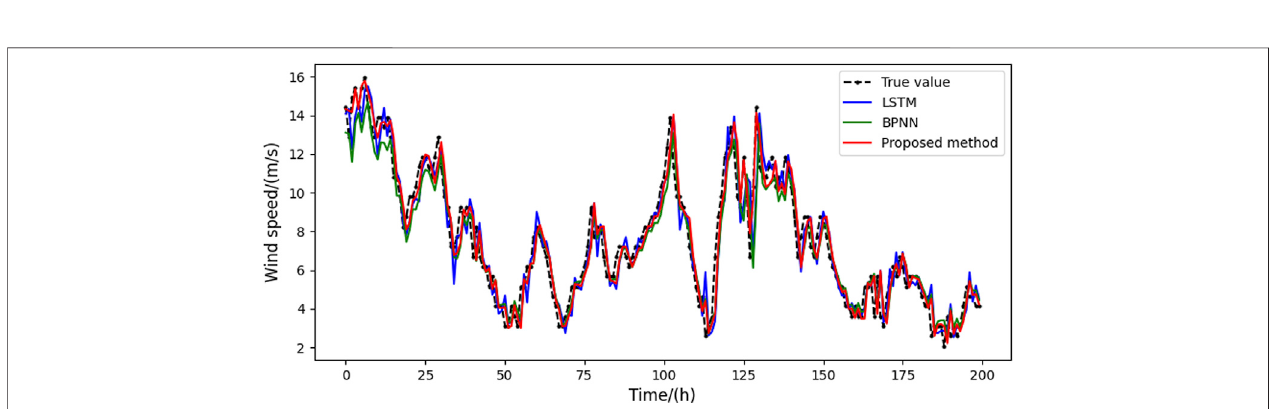
FIGURE 6 | Prediction results of three different methods in autumn.